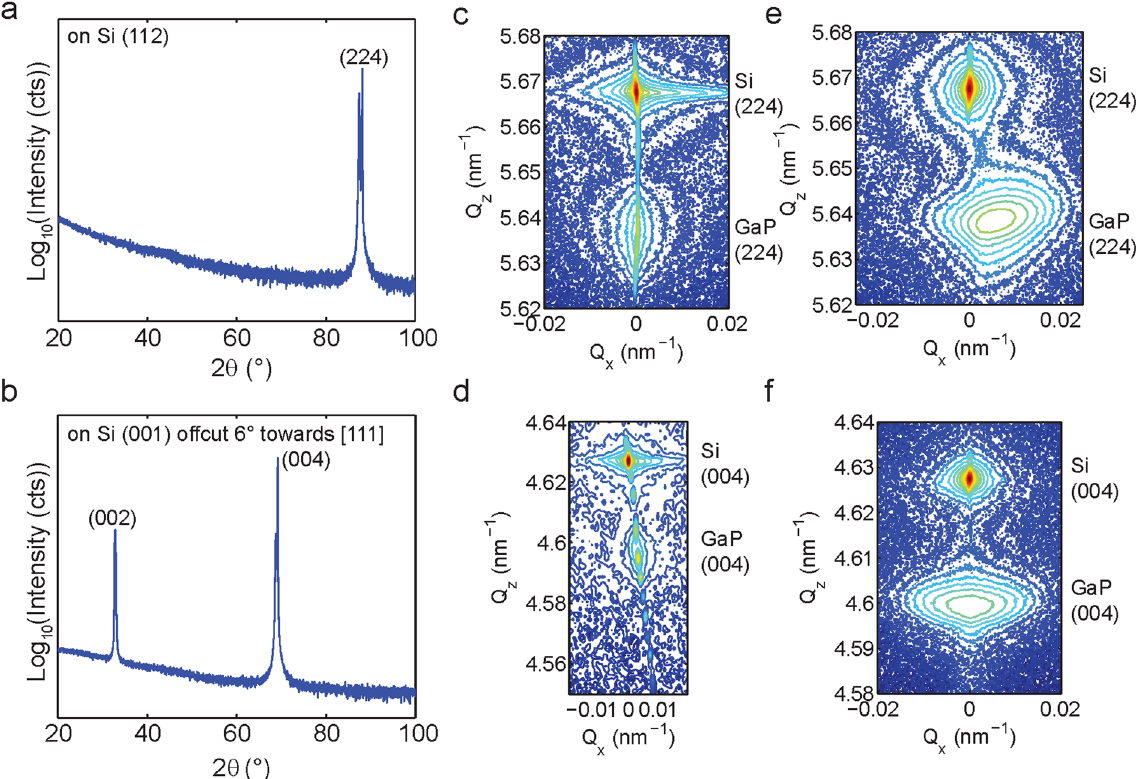
Figure 1. High resolution x-ray diffractometry of GaP films grown on Si. ( a ), ( b ) x-ray diffraction spectra of ~200 nm thick GaP films grown on (112) and (001) offcut 6° towards [111] substrates, respectively. The amorphous background is due to the use of a glass slide onto which the 1 × 1 cm sample is mounted. ( c ), ( d ) reciprocal space maps of ~50 nm thick films. ( e ), ( f ) reciprocal space maps of ~200 nm thick